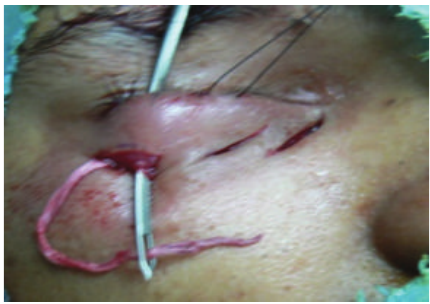
Figure 3: Intraoperatively Wright’s fascia needle was used to pass the free end of the fascia strip from skin to conjunctival incision.